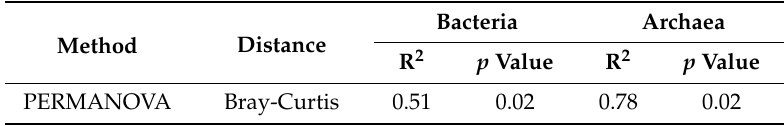
Figure 2. The principal-coordinate analyses (PCoA) analysis on operational taxonomic unit (OTU) levels of main bacterial ( a ) and archaeal ( b ) genera from > 0.45 µ m (green dots) and 0.2–0.45 µ m (red squares) size fractions. BP and BF represent bacteria of > 0.45 µ m and 0.2–0.45 µ m size fractions, respectively. AP and AF represent archaea of > 0.45 µ m and 0.2–0.45 µ m size fractions, respectively. The values of 1–4 represent four parallel samples. Table 2. Calculations of Statistic R 2 and p values using the PERmutational Multivariate ANalysis of VAriance (PERMANOVA) approach.